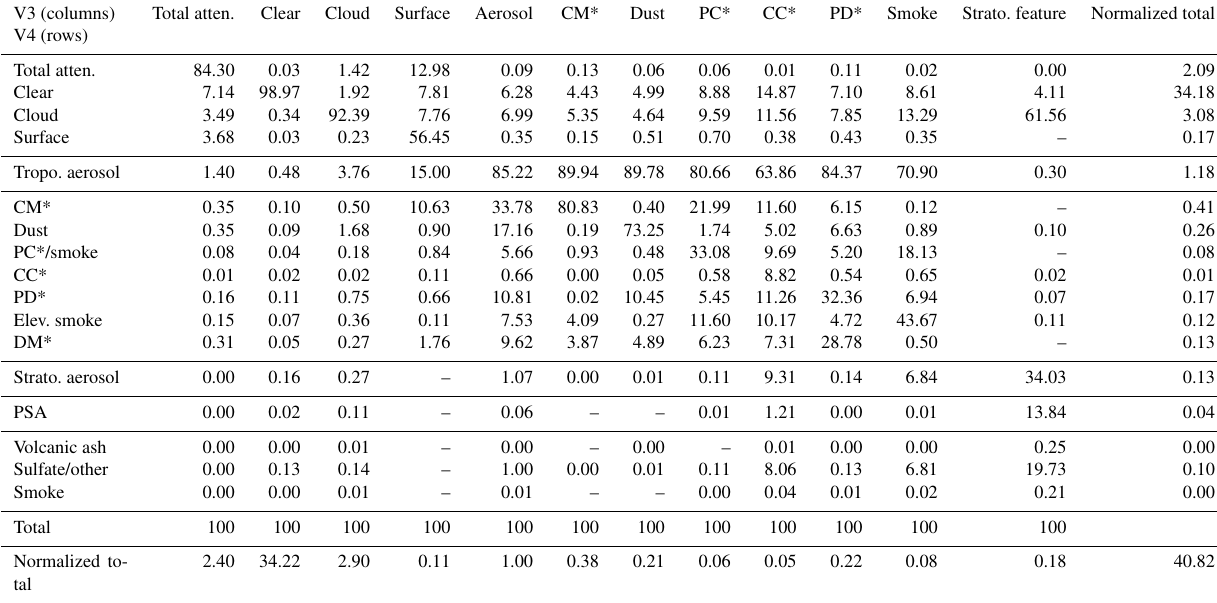
Table 4. Feature type and aerosol subtype changes in the CALIOP level 2 atmospheric volume description (AVD) between version 3 (V3) and version 4 (V4) from 2007 to 2009. Each (i,j) component of the table represents what fraction (expressed as a percentage) of type i in V3 changes to type j in V4; thus the summation of each column equals 100 (%). Since the total number of each type is different, relative total amounts for each type are shown as normalized total for both columns and rows, which are normalized to total number of bins for V3